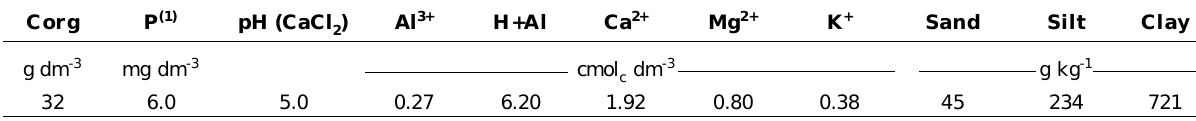
(1) Mehlich-1. *According to Pavan et al. (1992) and Embrapa (1997), respectively.